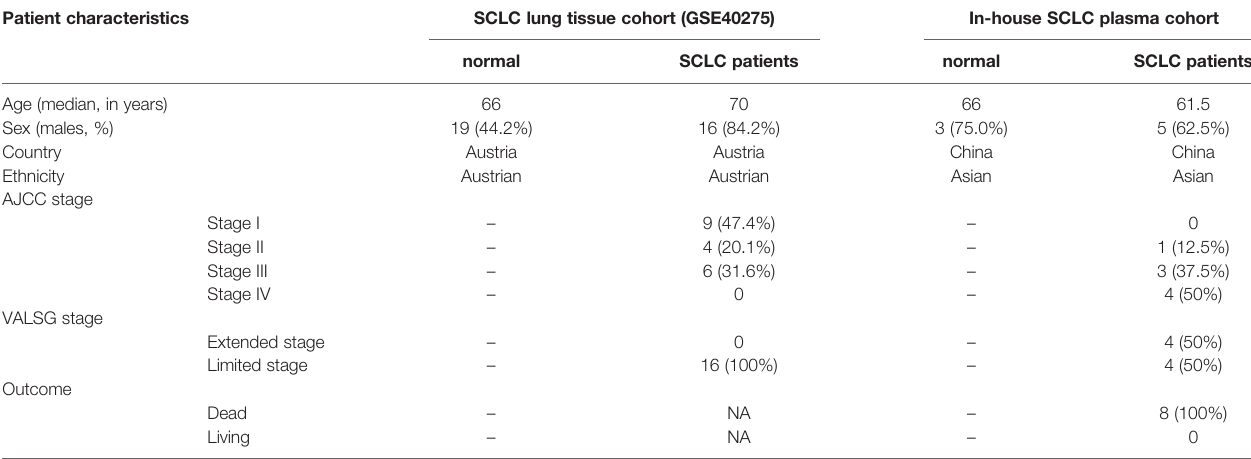
TABLE 1 | Patient characteristics for the in-house SCLC plasma cohort (n = 12) and SCLC lung tissue cohort (from GSE40275, n = 62). Patient characteristics